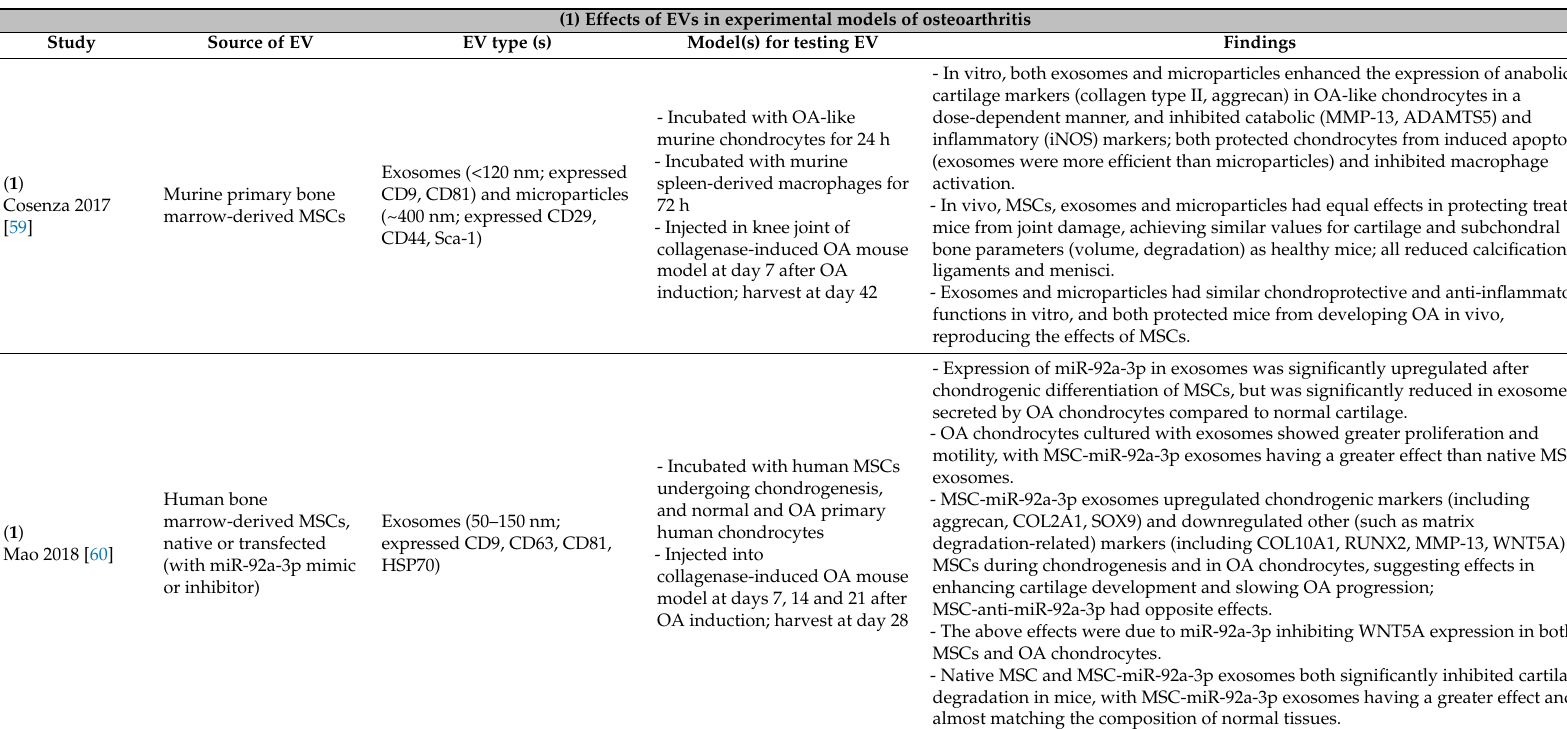
Table 1. Current evidence on the effects of EVs in joint injury and osteoarthritis. Breg = regulatory B-cell; DMM = destabilisation of the medial meniscus; ECM = extracellular matrix; ESC = embryonic stem cell; HUVEC = human umbilical vein endothelial cells; ICRS = International Cartilage Repair Society; IFN = interferon;